Question: Which visualization type does this figure use?
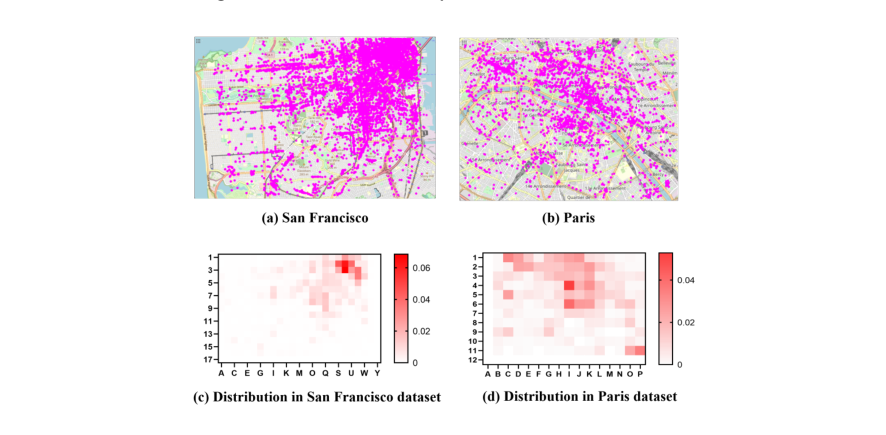
Answer: heatmap